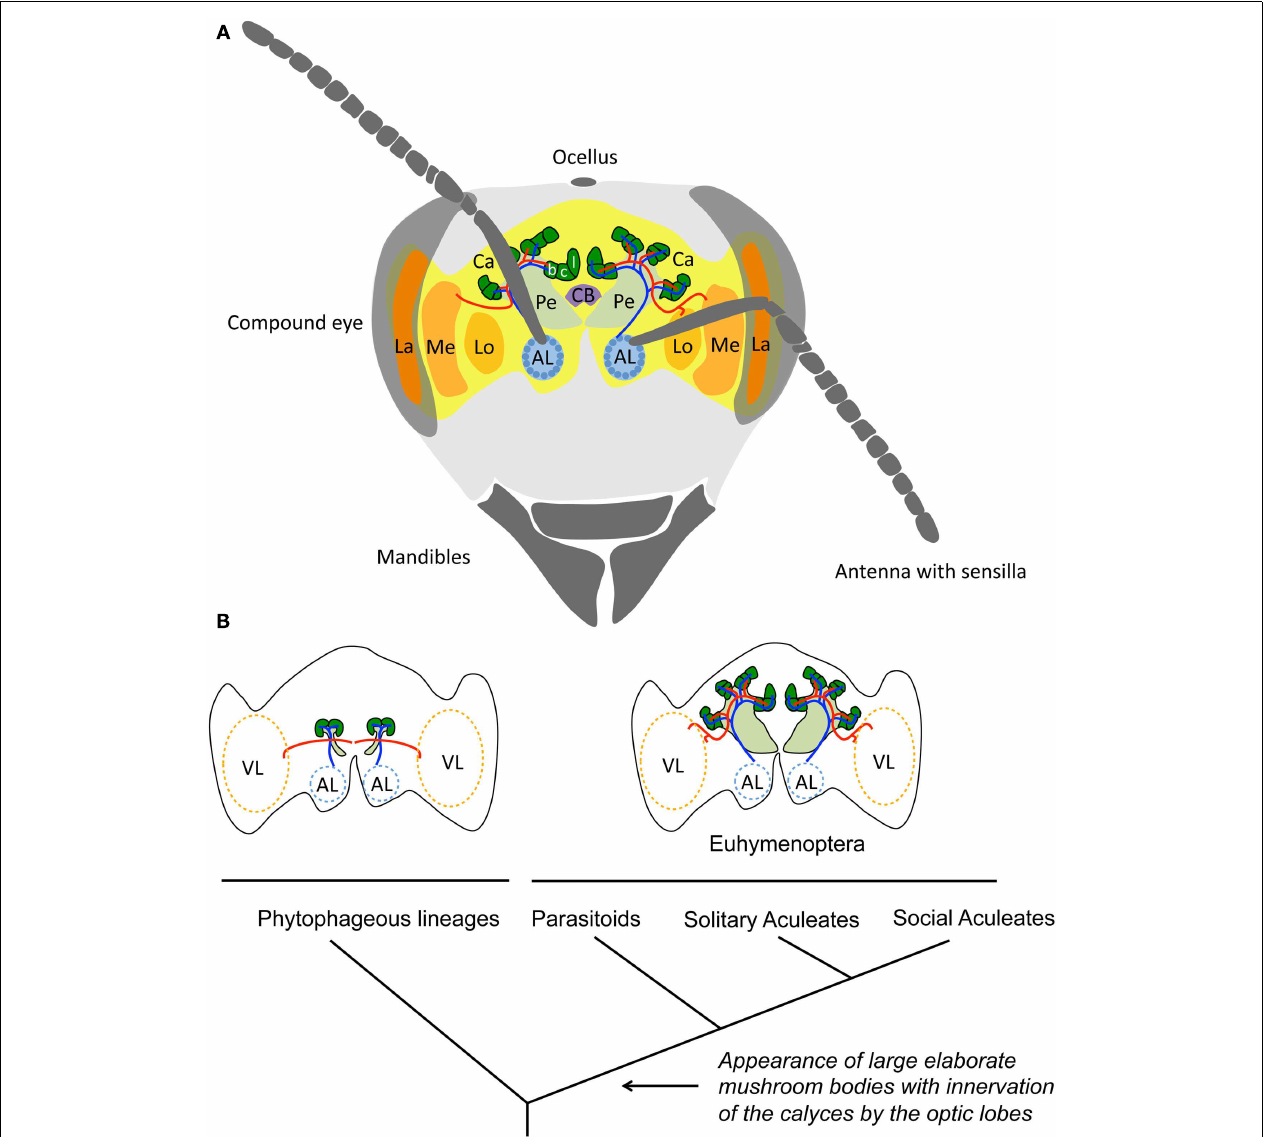
ring (b), which receives combined input from the antennal and visual lobes. The central body (CB) has connections to all major parts of the brain and is involved in leg coordination and motor control. Image modified from Menzel and Giurfa (2001). (B) Schematic representation of the morphology of the mushroom bodies of Hymenoptera, mapped on a simplified phylogeny, based on Farris and Schulmeister (2011).The mushroom bodies of phytophageous lineages are small, the calyces lack subcompartmentalization and do not receive visual inputs from the optic lobes. Large mushroom bodies with lip, collar and basal ring subcompartments in the calyx, and visual inputs arose concurrent with the acquisition of a parasitoid mode of life at the base of the Euhymenopteran, ca 90My prior to the evolution of social aculeates, such as